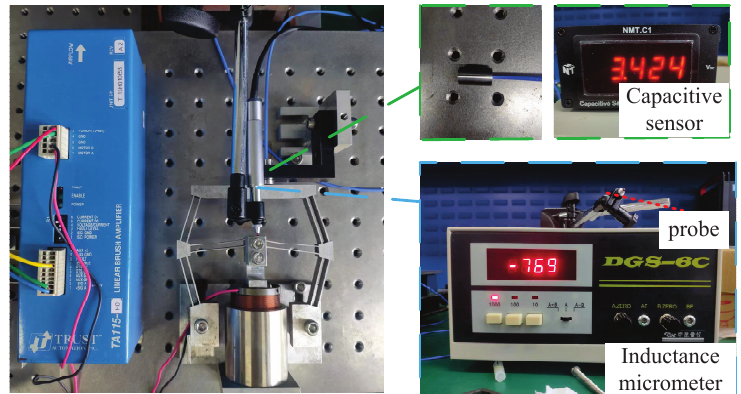
Figure 8. The experimental setup for the reduction ratio test.